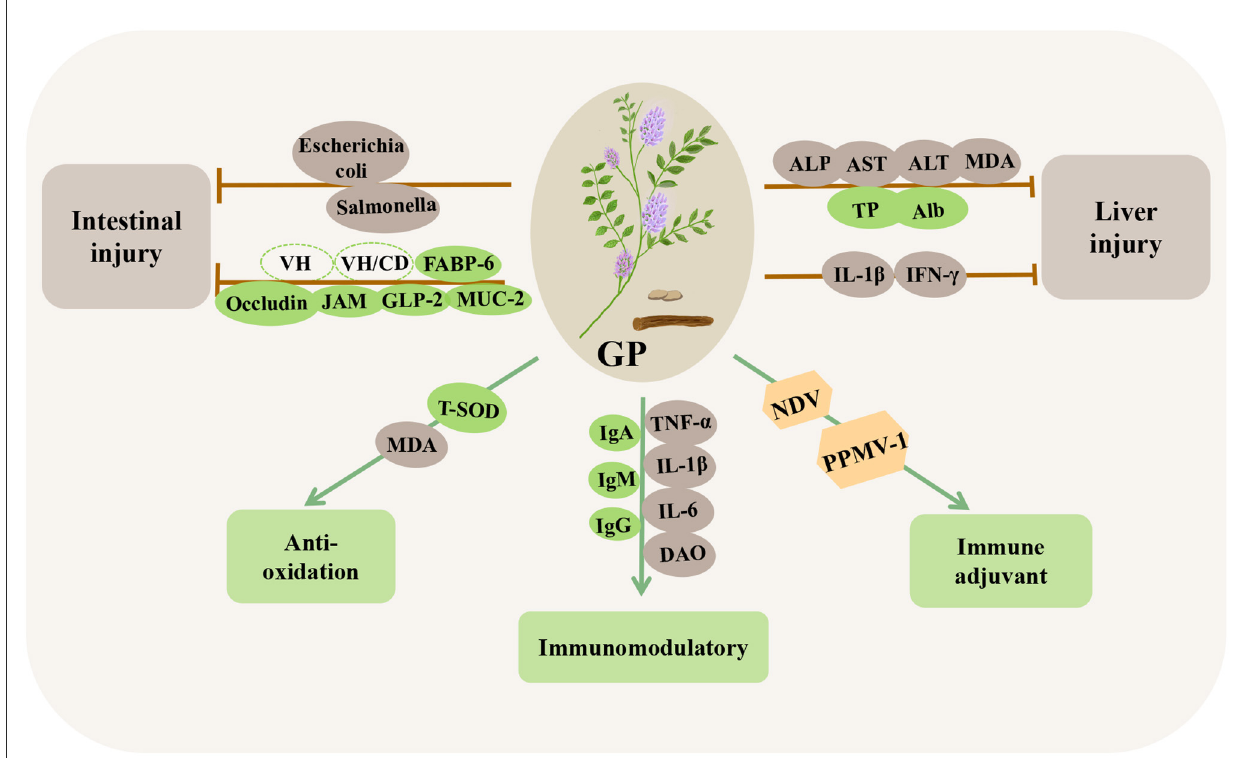
FIGURE9 Immunomodulatory and disease-resistant effects of Glycyrrhiza polysaccharides (GPs) in poultry. VH, villus height; VH/CD, villus height/crypt depth; FABP-6, fatty acid binding protein 6; Occludin, tight junction proteins; JAM, junction adhesion molecules; GLP-2, glucagon-like peptide-2; MUC-2, mucin-2; PPMV-1, paramyxovirus type 1; ALP, alkaline